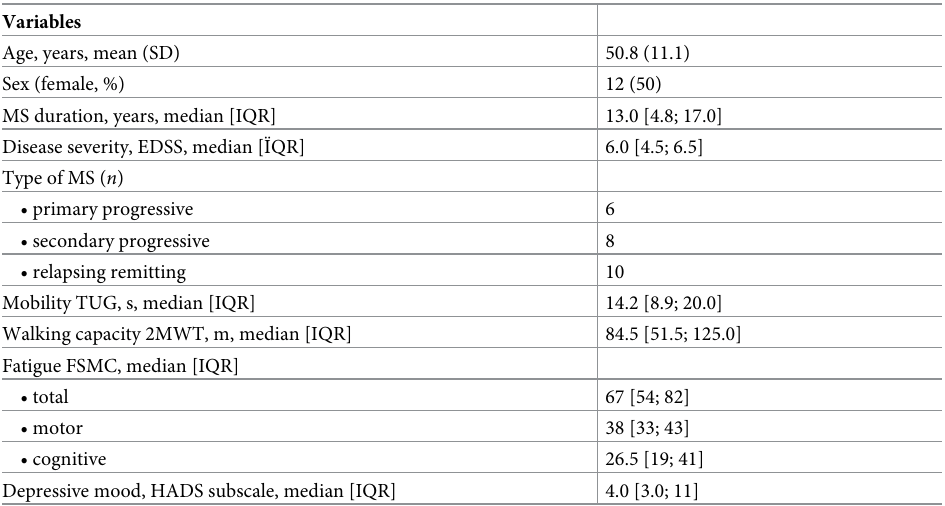
Table 1. Baseline characteristics of the 24